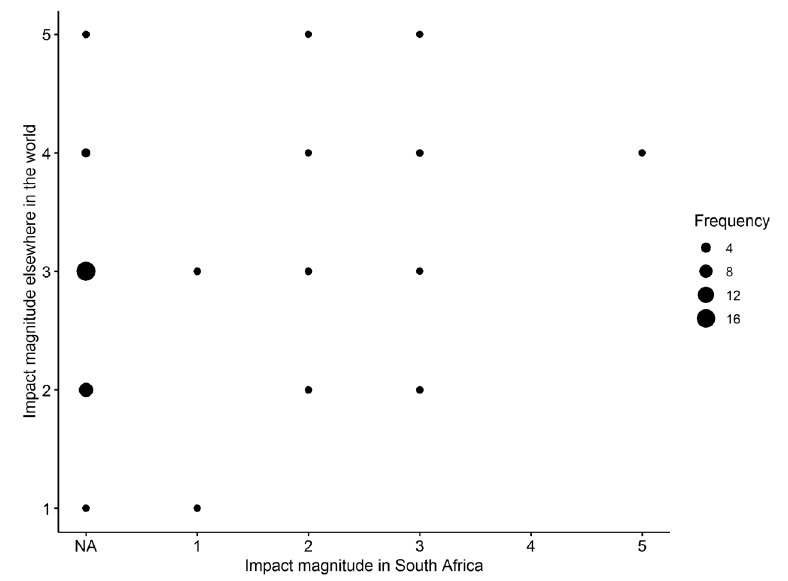
Figure 3. Comparison between impact magnitude of alien grasses in South Africa and elsewhere in the world. The values 1 to 5 on the x- and y-axis represent the GISS impact magnitudes and NA indicates no impact record found. The size of the points represents the frequency of species with impacts